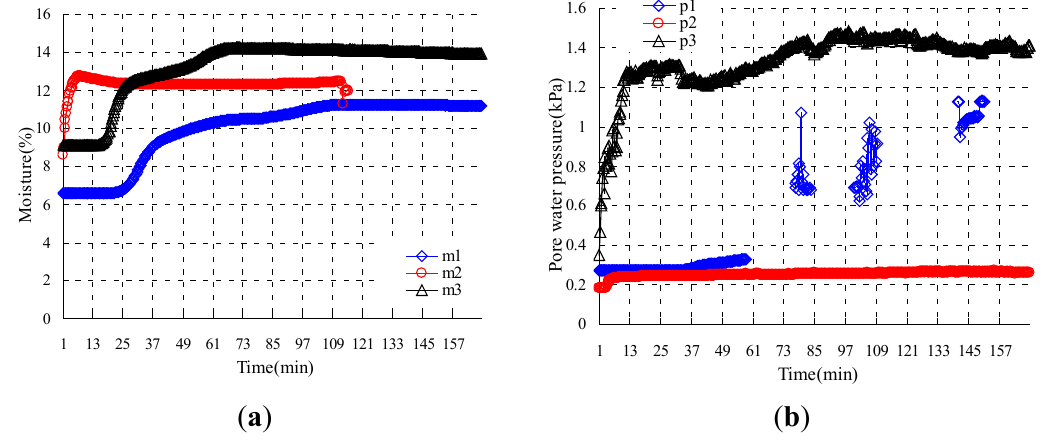
Figure 10. Soil Sample 2-45 mm/h: ( a ) Moisture content of m1, m2, and m3; and ( b ) pore water pressure of p1, p2, and p3.